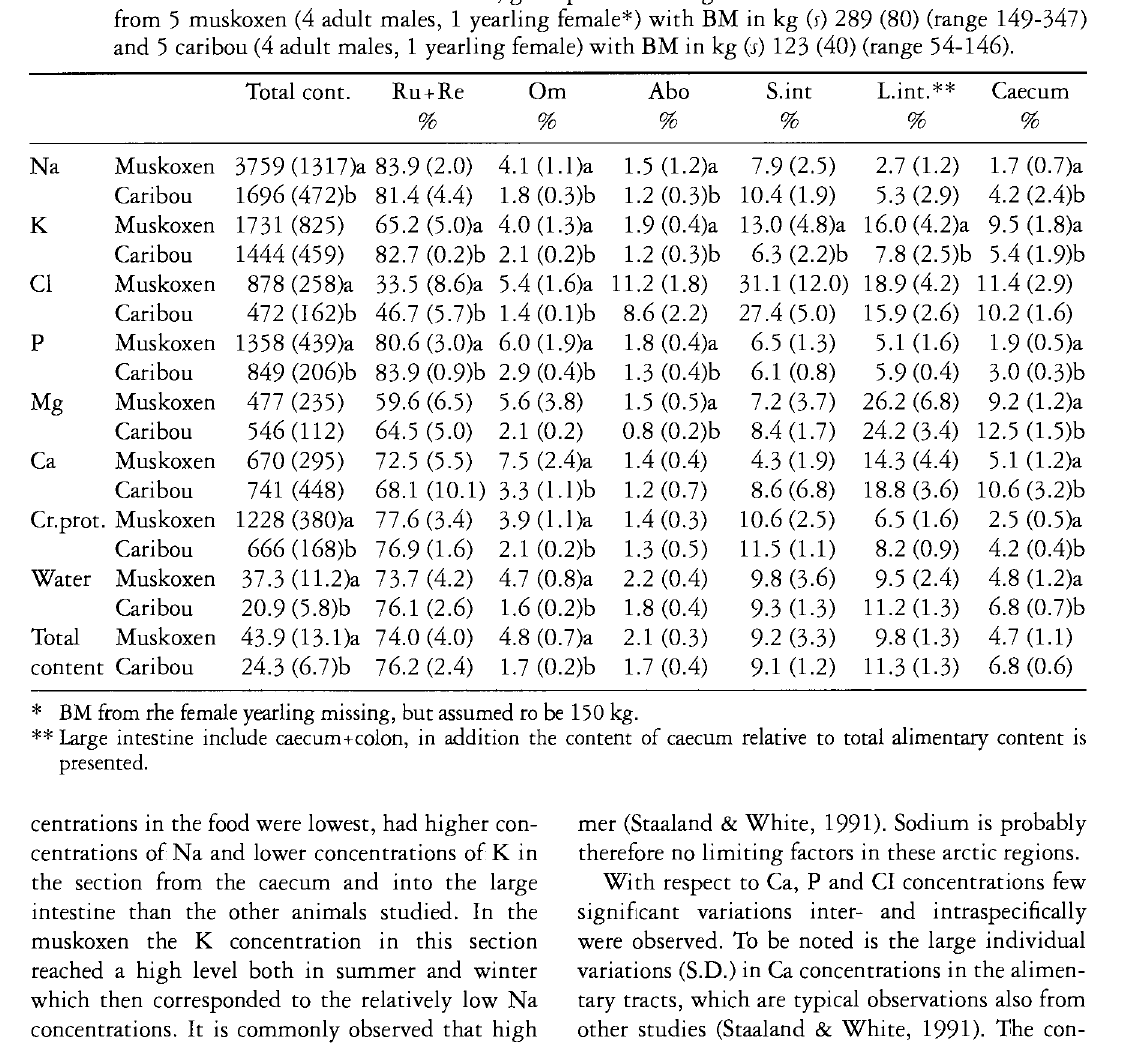
Table 2. Total alimentary content, and alimentary pools of minerals, crude protein and water in the alimen tary system [mean (standard deviation)] of muskoxen and caribou collected on Greenland in August 1990 (Figures followed by different letters are significantly different, ?-test P< 0.05). Total pools are measured in mmol for all minerals, g for protein and kg for water and total content. Data are from 5 muskoxen (4 adult males, 1 yearling female*) with BM in kg (r) 289 (80) (range 149-347) and 5 caribou (4 adult males, 1 yearling female) with BM in kg (s) 123 (40) (range 54-146). Total